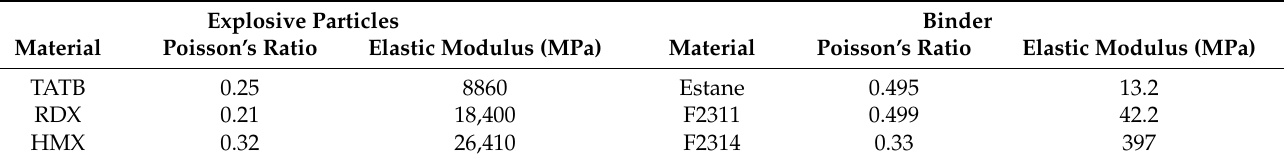
Table 1. Material parameters of the explosive particles and